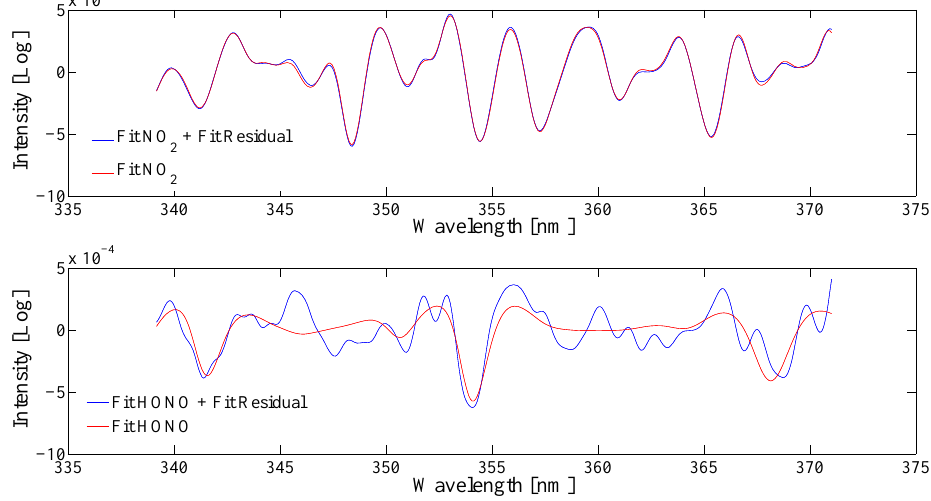
Fig. 2. Example spectra for NO 2 (upper) and HONO (lower) analysis. Shown is a comparison of the HONO absorption cross section after adaptation to the instrument function, simulation of the multichannel scanning technique (MCST) procedure, and smoothing, compared to the spectral features after removal of all other trace gas absorptions except NO 2 (upper) and HONO (lower). The retrieved HONO mixing ratio was 0.139 ± 0.013ppb while NO 2 was 5.38 ±